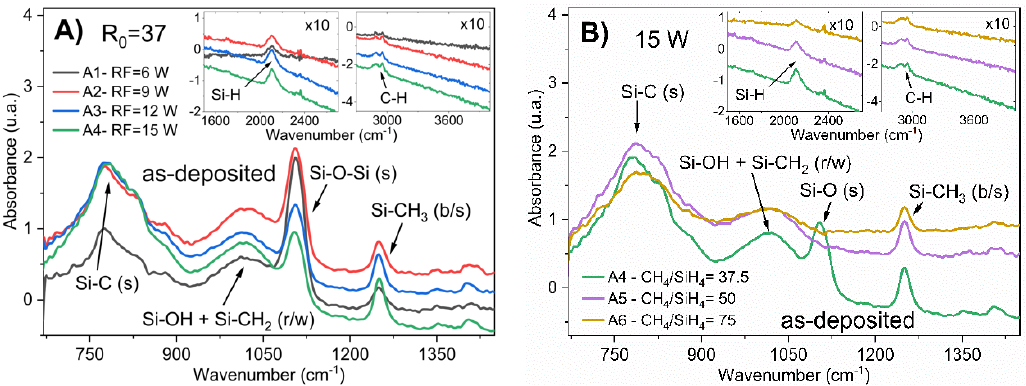
Figure 1. FTIR spectra of as-deposited a-Si 1 – x C x :H films: ( A ) with different RF power (6 – 15 W) at a constant ratio of CH 4 /SiH 4 (R 0 = 37.5); and ( B ) corresponding to films deposited with different CH 4 /SiH 4 ratios (R 0 from 37.5 to 75) with a constant RF power of 15 W.